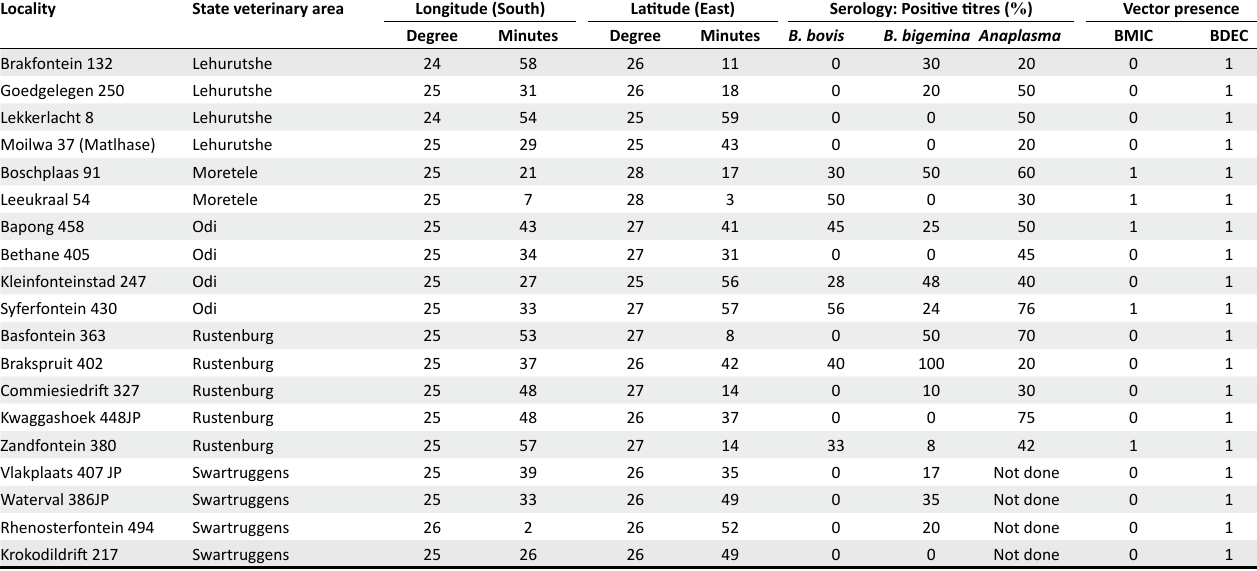
FIGURE 11: The geographic distribution of Rhipicephalus simus in the North West province, South Africa. TABLE 3: Serology results from livestock at various localities and associated presence or absence of